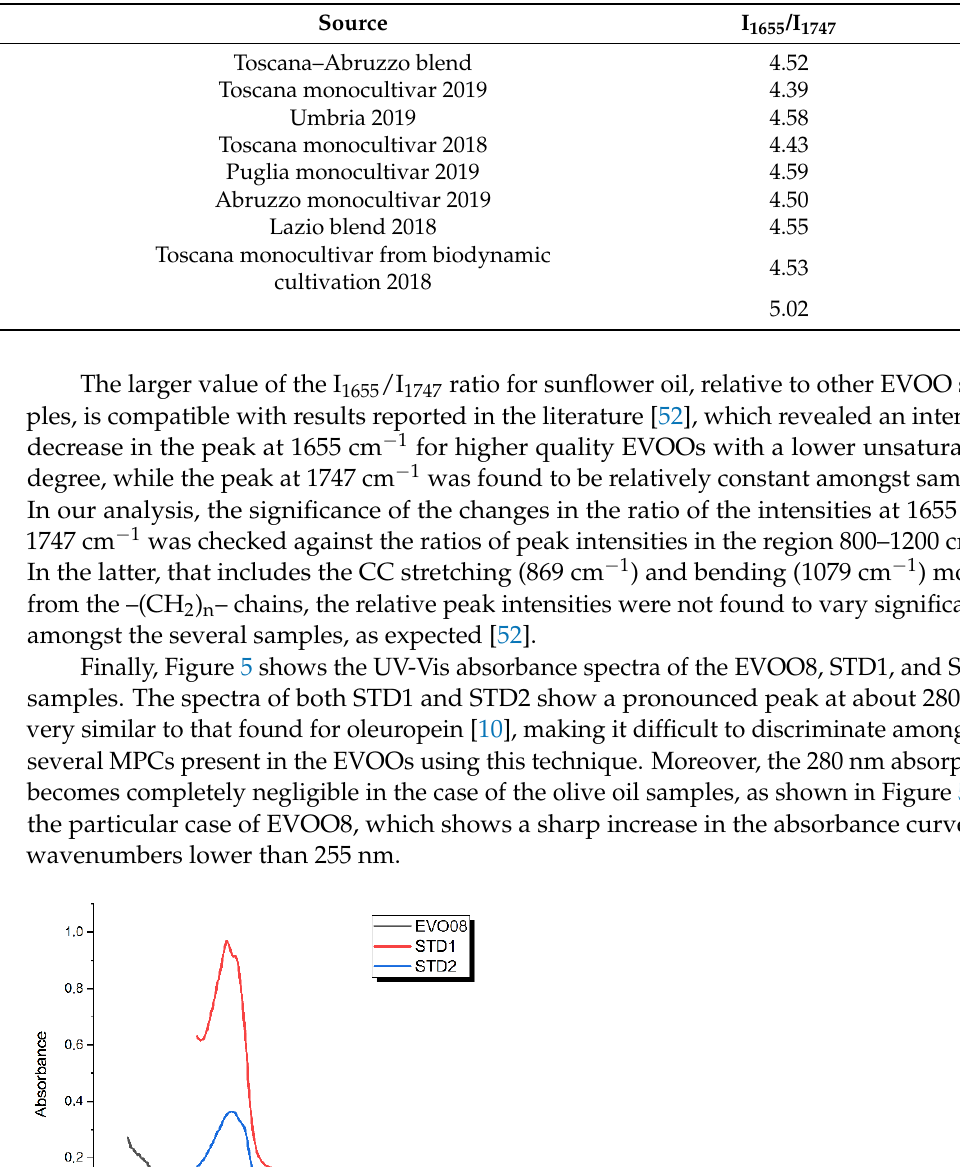
Table 2. Raman intensity ratios for the bands at 1655 and 1747 cm − 1 ( ν C = O from phenolic acids and esters, respectively), for the extra virgin olive oils and sunflower oil in the present study.